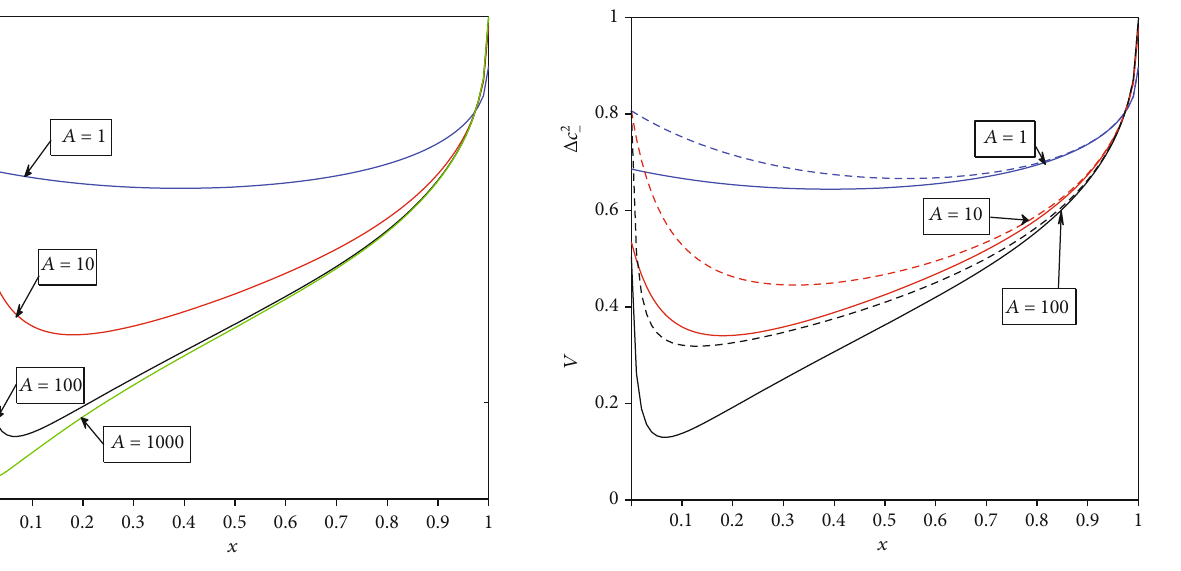
Figure 10: The smallest eigenvalue V of the two-mode cavity radiation versus x for κ = 0 : 5 , ε = 0 : 06 , and di ff erent values of A .